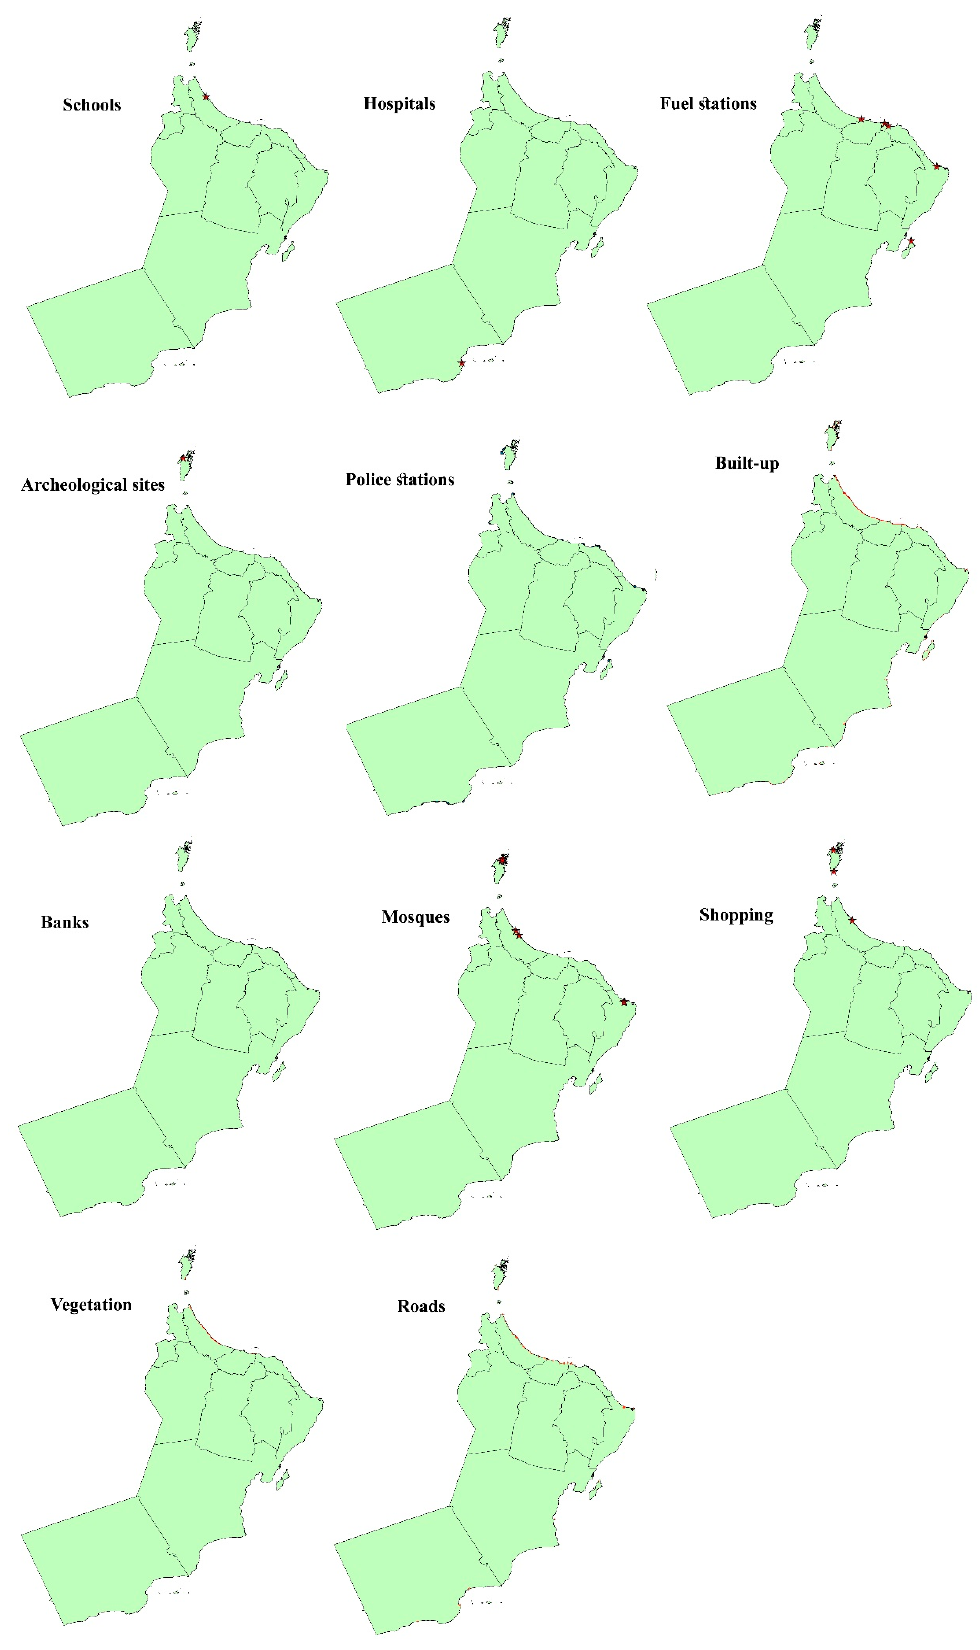
Figure 5. The distribution of the impacted infrastructure features by a 5 m run-up height tsunami.